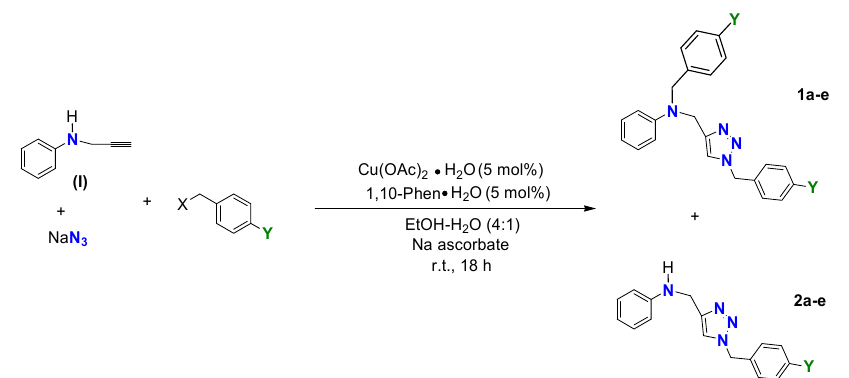
Table 1. Synthesis of mono- and dibenzylated